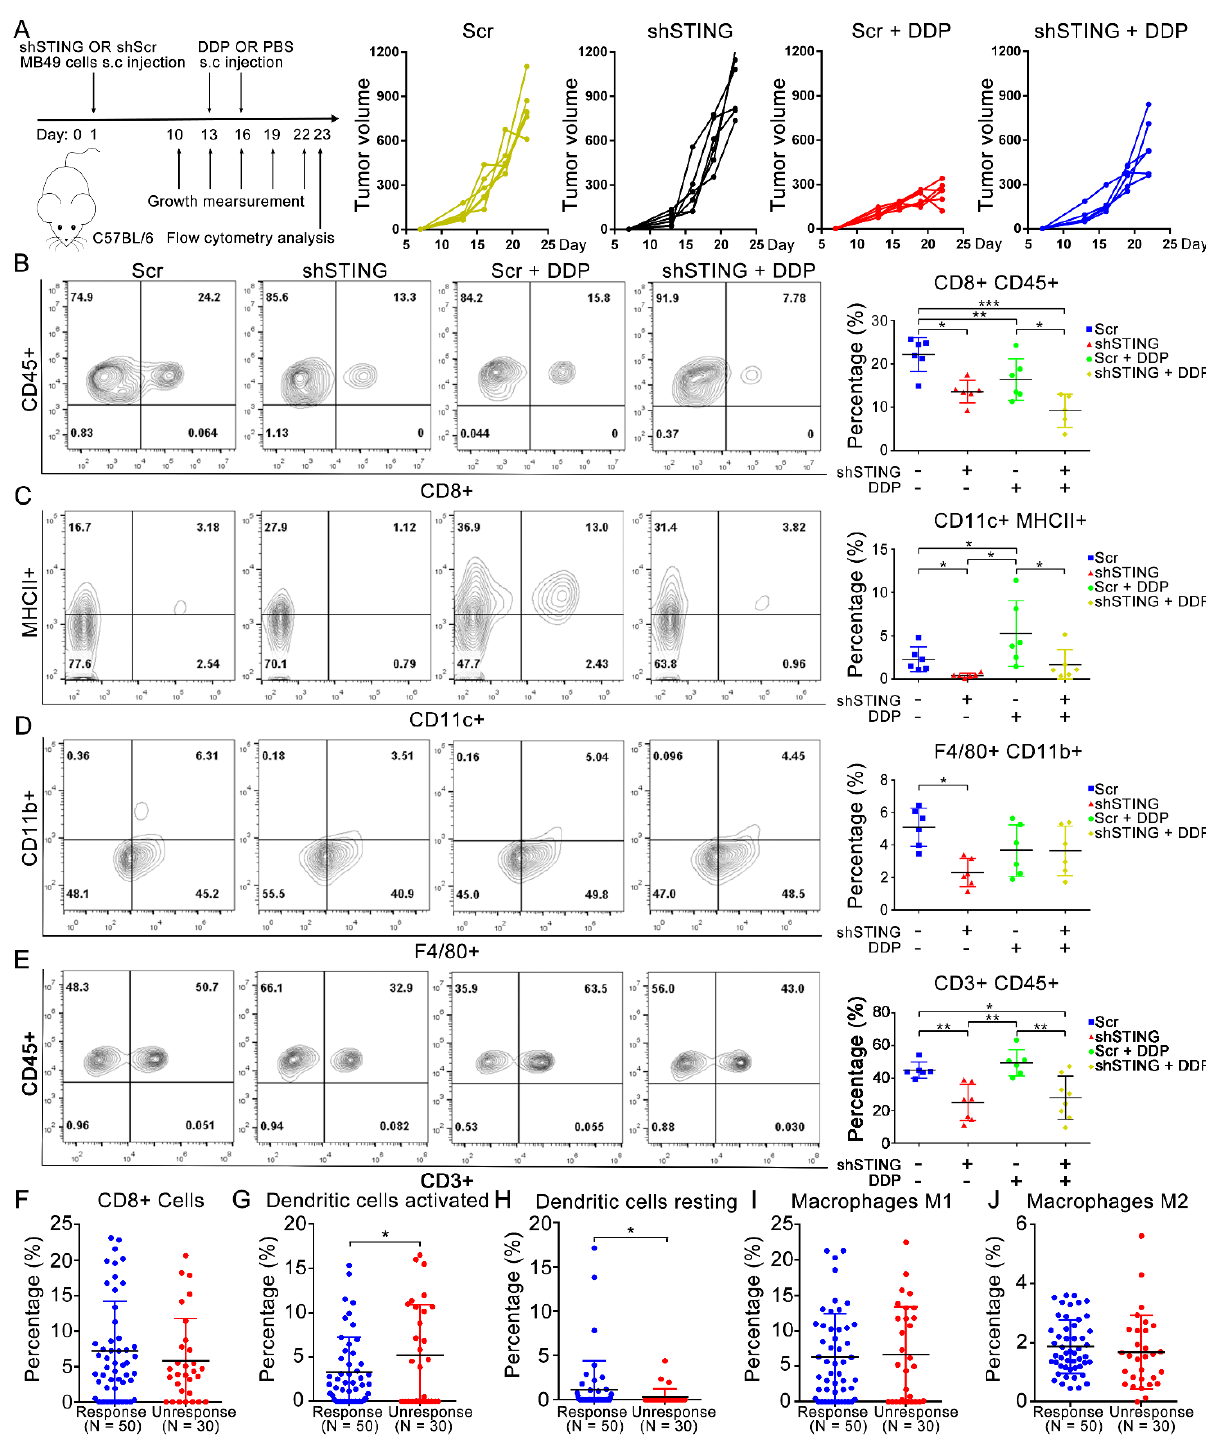
Figure 4. Activation of cGAS-STING suppressed bladder cancer in cisplatin-treated C57 mice. ( A ) Establish of bladder cancer transplantation models in C57 mice, left. Tumor volumes of different groups, right. ( B – E ) Infiltration percentages of ( B ) CD8+, CD45+ T cells, ( C ) CD11b+, MHC Ⅱ + DCs, ( D ) F4/80+, CD11c+ Macrophage, ( E ) CD3+, CD45+ cells in MB49 transplantation tumors. ( F – J ) CYBERSORT predicted infiltration percentages of CD8+ T cells ( F ), DCs activated cells ( G ), DCs resting cells ( H ), Macrophages M1 cells ( I ), and Macrophages M2 cells ( J ) in response group ( n = 50, CR or PR) was significantly higher than non-response group ( n = 30, PD or SD) after cisplatin-based chemotherapy. * p < 0.05, ** p < 0.01, *** p < 0.001. DDP, cisplatin.